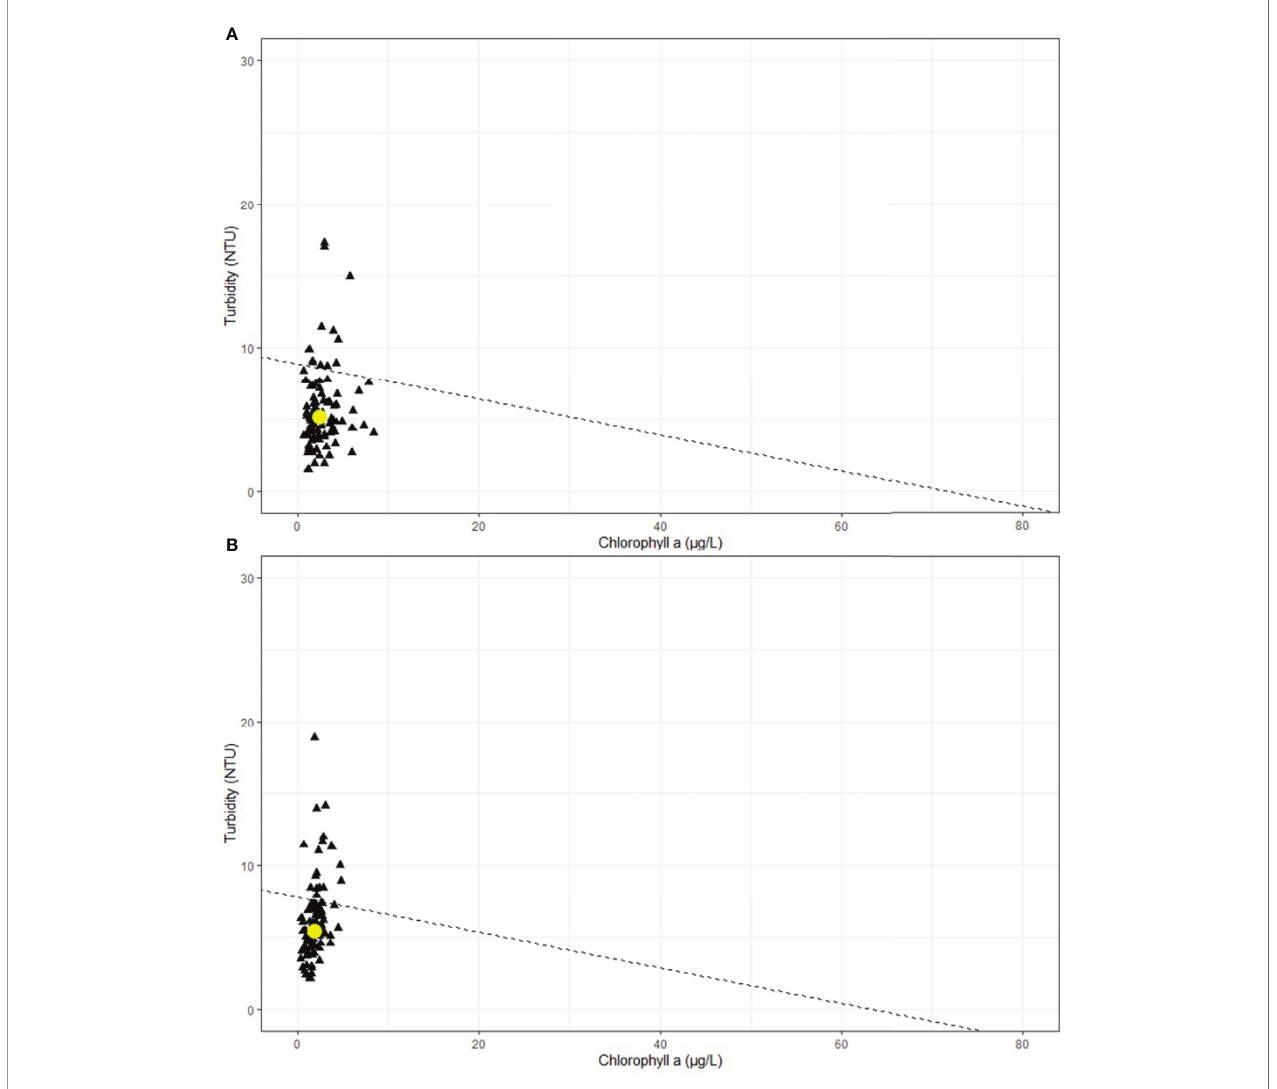
FIGURE 11 | Inverted bio-optical model output for both (A) WQ2 and (B) WQ3 in Back Sound, NC. Yellow circle is median chl and turbidity value. Dashed line is the line of constant attenuation (22% I 0 at